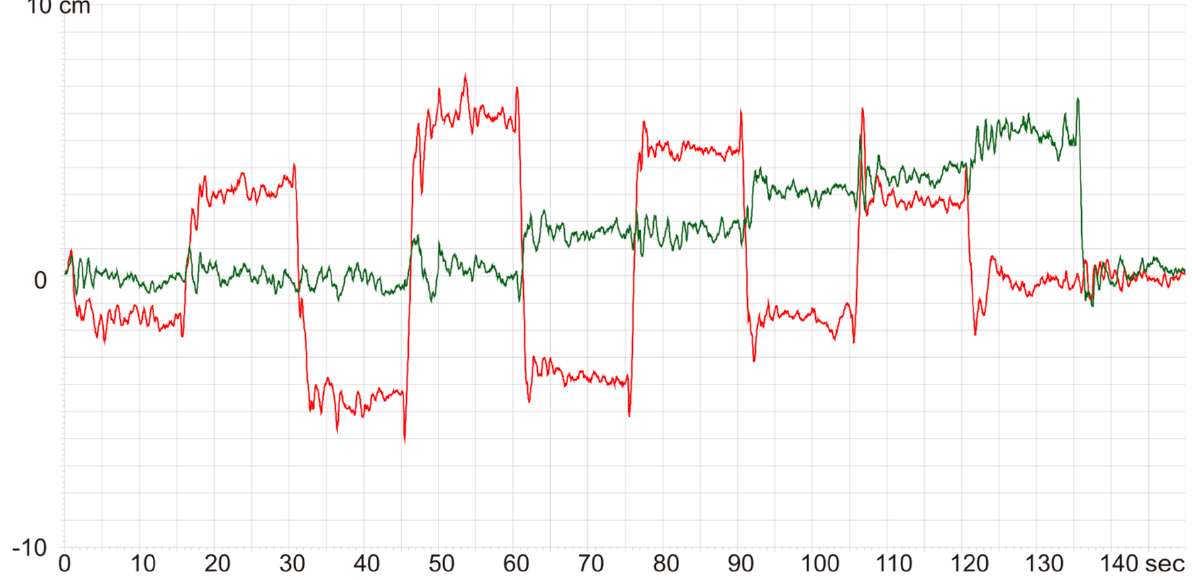
Figure 3. The x(y) and y(t) stabilograms for the force plate training. The green stabilogram shows movements in the y -axis in the sagittal—anteroposterior (AP) plane; the red one, in the x -axis, i.e., in the frontal—mediolateral plane (ML). Table 3. Variables: mean sway radius R and K% coefficient for feedback measurement for all individuals in examinations I and II. The cells contain the number of patients meeting the given inequality.